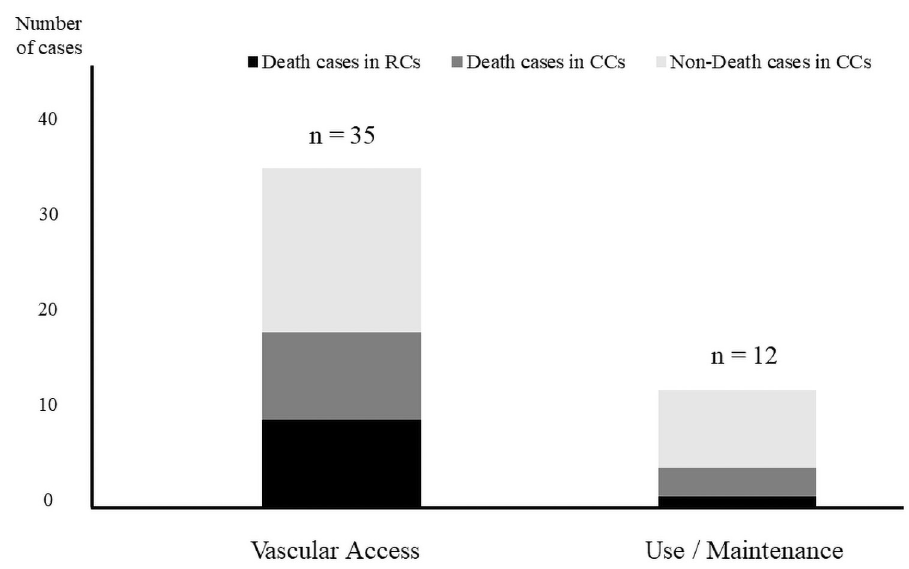
Fig 1. Number of CCs or RCs related to vascular access or to use/maintenance classified according to error type. In CCs, no significant difference was observed between the proportion of deaths due to errors in obtaining vascular access and that due to use/maintenance (p = 1.00). CC, closed-claim case; RC, reported case. https://doi.org/10.1371/journal.pone.0261636.g001 catheterization [6–8, 26]. Therefore, recommendations published by Medsafe Japan and ISC describe in detail the appropriate puncture technique under ultrasound guidance at the jugular vein, which can be expected to reduce CVC-related deaths by incorporating this into clinical practice. Some deaths in CCs may have been avoided using the ultrasound-guided method. However, bleeding complications in CVC cannot be completely avoided, even if catheteriza- tion is performed with appropriate use of the ultrasound-guided method. In the death cases due to internal jugular vein puncture, concomitant coagulopathy is conspicuous, and fatal complications due to bleeding may occur regardless of the use of ultrasound guidance. The risk of bleeding complications at CVC in patients with coagulopathy is well recognized among physicians. However, data indicate that vascular injury that occurs in patients with Table 4. Complication types related to vascular access in the death cases �